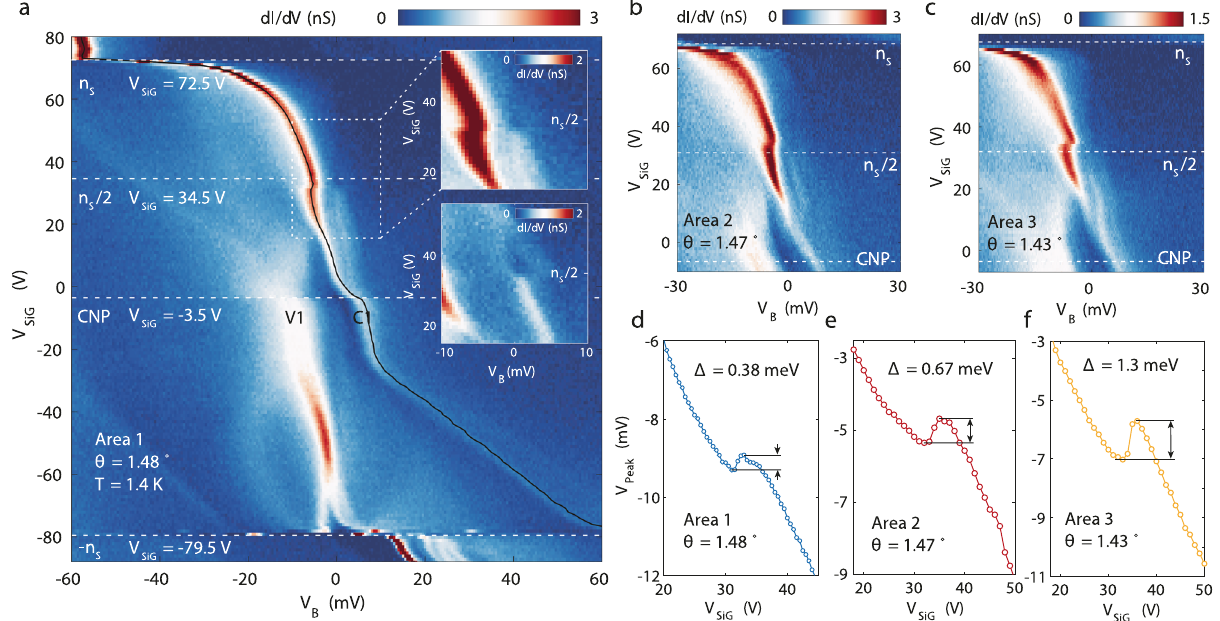
Fig. 4 Evidence for correlated insulating states at half fi lling of the conduction band. a High-resolution gate-dependent spectra in the fi rst area with θ = 1.48°, taken near the ABAB stacking con fi guration with V set = − 400 mV, I set = 800 pA and V mod = 0.5 mV. There is a clear jump of vHs near the half fi lling of the conduction band. Top inset, zoom-in around the half fi lling and zero bias, revealing a small dip in tunneling conductance at zero bias near half fi lling. Bottom inset, a zoom-in of Supplementary Fig. 2, showing a more pronounced gap near half fi lling. b , c High-resolution maps showing similar jumps of vHs in different areas of the sample with twist angles 1.47° and 1.43°, also taken with V mod = 0.5 mV. d – f Traces of vHs peaks over silicon gate voltages in three different areas. The magnitude of the jump 4 in each area is